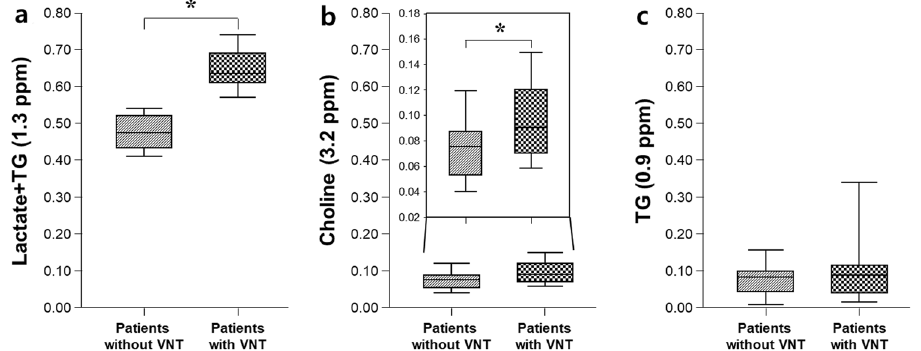
Figure 1. Quantitative comparison of the cellular metabolites for ( a ) lactate + TG (1.3 ppm), ( b ) choline (3.2 ppm), and ( c ) TG (0.9 ppm) in cirrhotic patients with and without VNT. The differential metabolite levels between the two groups were analyzed using an analysis of covariance (ANCOVA) with adjustments for age and sex at P < 0.05. * Significant difference between cirrhotic patients with and without VNT. TG, triglyceride; VNT, varices needing